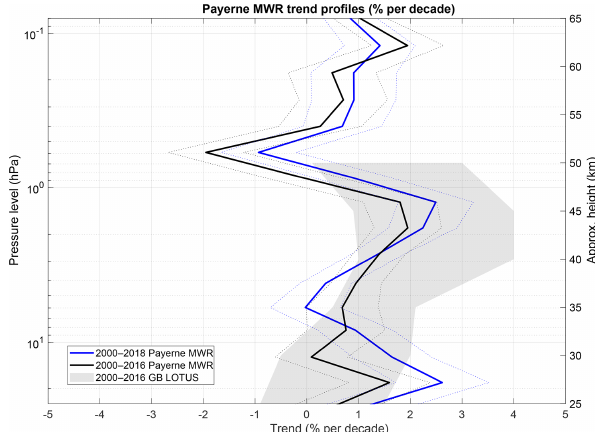
Figure 7. Payerne MWR O 3 trend profiles for the 2000–2016 time range in black and 2000–2018 time range in blue. The dotted lines show the 2 σ uncertainties. The shaded area is the full range of LO- TUS ground-based 2000–2016 trend